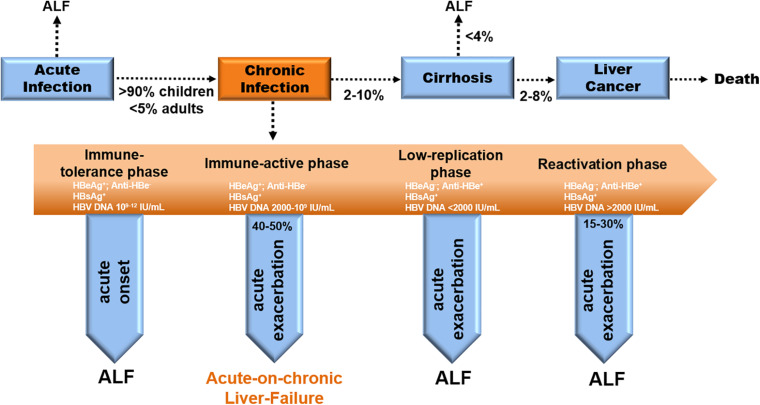
Natural history and disease progression in CHB patients. Evolution to CHB occurs in > 90% of children and < 5% of adults with acute HBV infection. Progression to cirrhosis from CHB appears to be 2–10% per year. The incidence of ALF from cirrhosis is less than 4% yearly. The rate of cirrhosis to liver cancer is 2–8% annually (EASL Jury, 2003). ACLF occurs in the IA phase (40–50%) during chronic infection (Sheen et al., 1985; Lok et al., 1987).